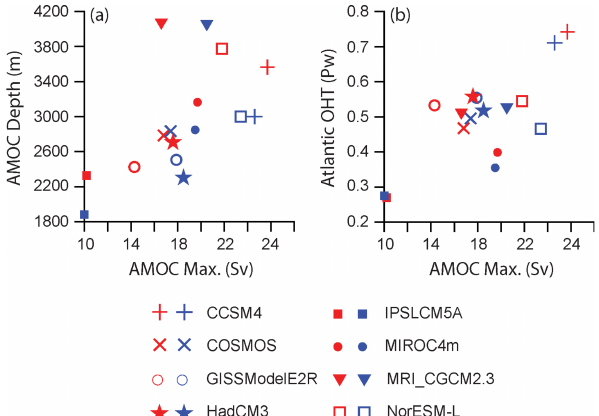
Fig. 3. (a) Maximun AMOC values vs. mean depths of AMOC cells. (b) Maximun AMOC values vs. mean values of ocean heat transport in Atlantic between 30 ◦ S and 80 ◦ N. Pre-industrial ex- periments are marked in red, and mid-Pliocene experiments are in